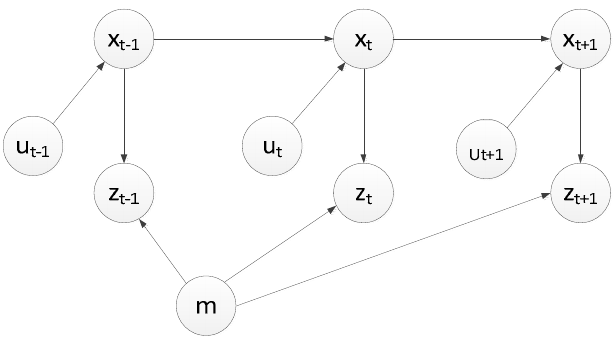
Figure 5. Schematic model of the simultaneous localization and mapping (SLAM) problem.